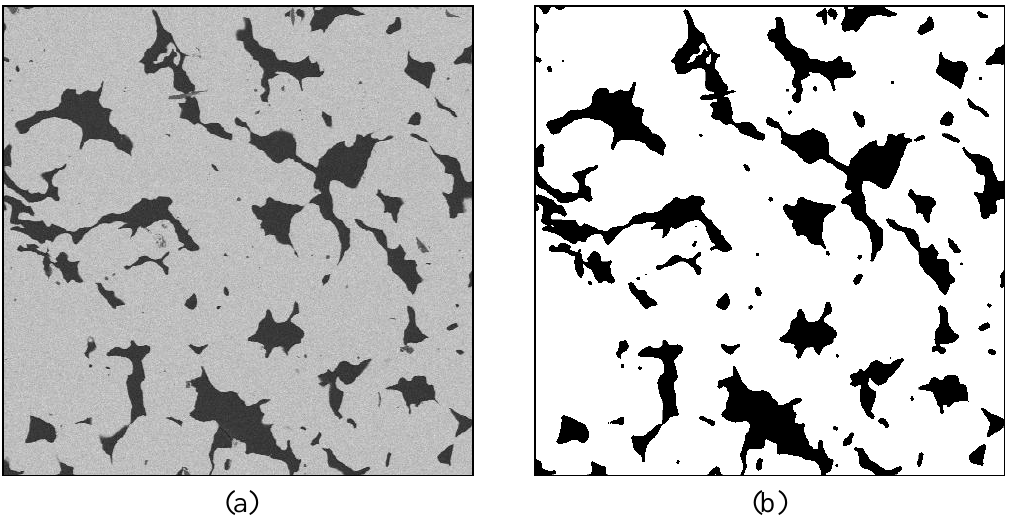
Figure 3. Part of back-scatter electron (BSE) image of the porous filter F1 (magnification 200  , cut size 480  480 pixel, 0.5 micron/pixel). ( a ) Original intensity image, in which pores are dark grey and metal is light grey; ( b ) The same image after filtration and segmentation, pores are black and metal is white.